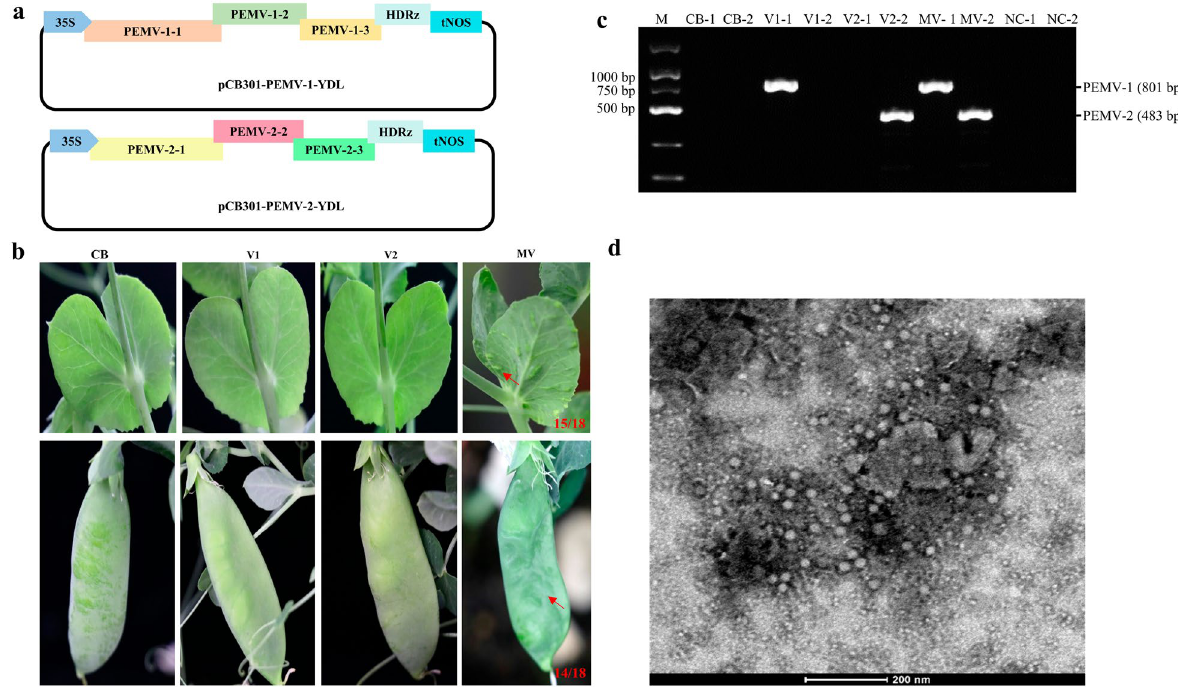
Fig. 4 Infectivity and pathogenicity of the infectious clones of PEMV-1-YDL and PEMV-2-YDL. a Schematic diagram illustrating the one-step assembly cloning strategy used to construct infectious full-length cDNA clones of PEMV-1-YDL and PEMV-2-YDL. Three overlapping fragments of PEMV-1-YDL and PEMV-2-YDL were amplified and inserted into the linearized pCB301 vector. 35S, the cauliflower mosaic virus promoter; HDRz, hepatitis delta virus ribozyme; tNos, Nos terminator. b Symptoms of systemic leaves and pods of pea (Taiwan Changshou) plants PEMV-1-YDL or PEMV-2-YDL or mixture of PEMV-1-YDL and PEMV-2-YDL using agro-infiltration. Red arrows indicated enations on the systemic leaves and pods. Pea plants and pods were photographed at 21 and 33 days post-infection (dpi), respectively. The plants were inoculated with Agrobacteria that harbor the pCB301 vector as a control. c RT-PCR detection of PEMV-1-YDL and PEMV-2-YDL in the inoculated pea at 21 dpi. ‘-1’ and ‘-2’ indicated RT-PCR detection using specific primers of PEMV-1 (801 bp) and PEMV-2 (483 bp). Lane M, DL 2000 DNA Marker; lanes CB, plants inoculated with pCB301; lanes V1, plants inoculated with PEMV-1-YDL; lanes V2, plants inoculated with PEMV-2-YDL; lanes MV, plants inoculated with PEMV-1-YDL PEMV-2-YDL; lanes NC, represent negative control. d Transmission electron micrograph of viral particles in the systemic leaves of pea + plants inoculated with PEMV-1-YDL PEMV-2-YDL via agro-infiltration. Bar 200 + =